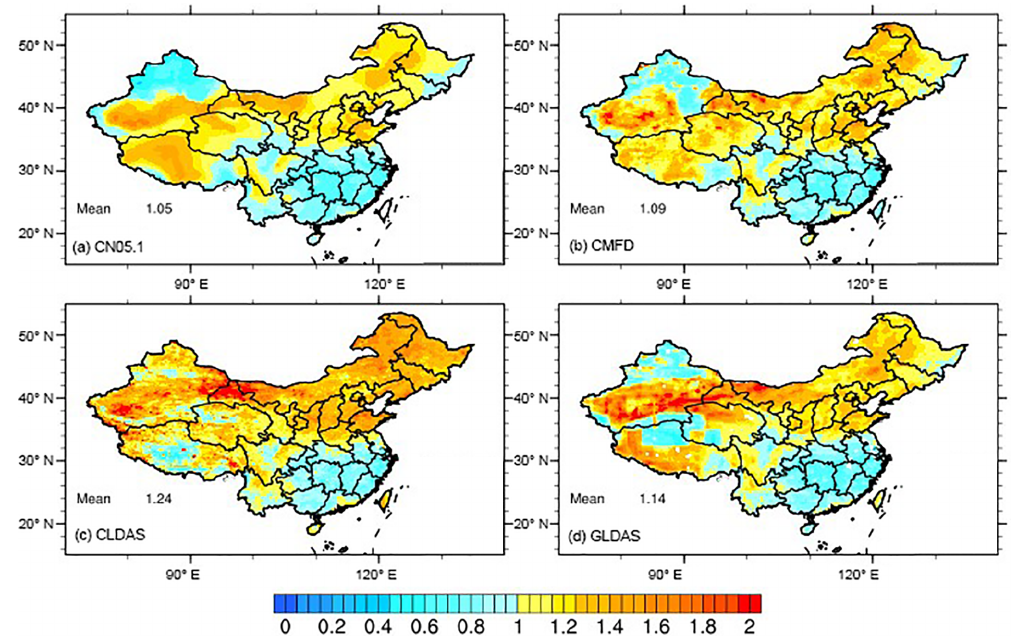
Figure 5. Distribution of TCV for precipitation products from (a) CN05.1, (b) CMFD, (c) CLDAS and (d) GLDAS during